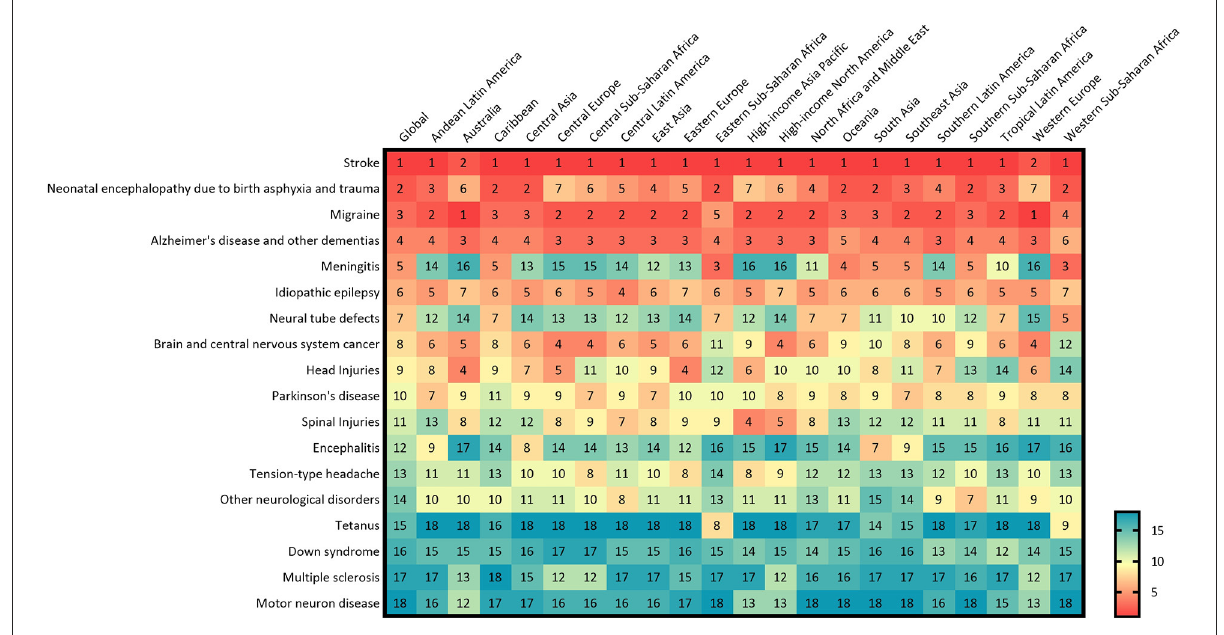
the SDI (all p < 0.001) (Supplementary Table S3). The burden of disease mainly impacted the early neonatal and late neonatal age groups (Figure